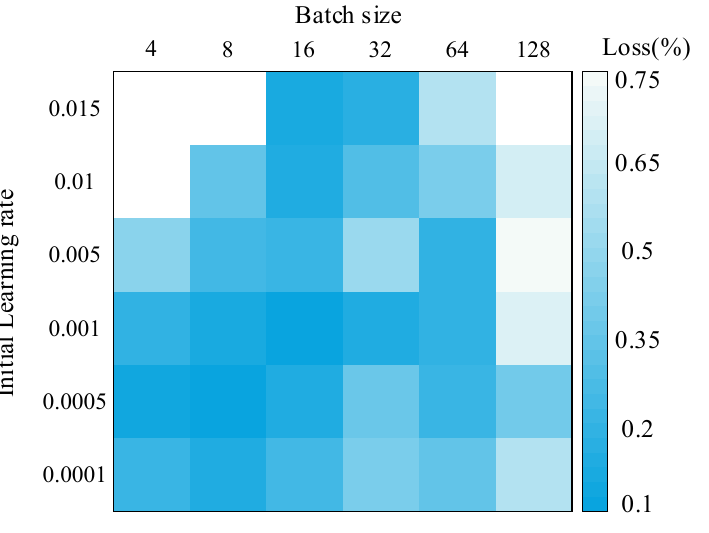
Figure 7. MAE under different hyperparameters: batch size and initial learning rate.